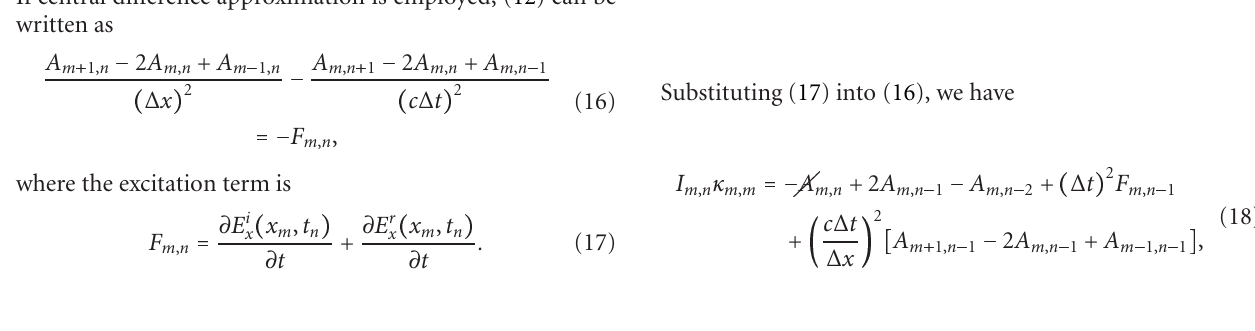
Figure 6: The incident and reflected wave on the height of thin wire with di ff erent incident